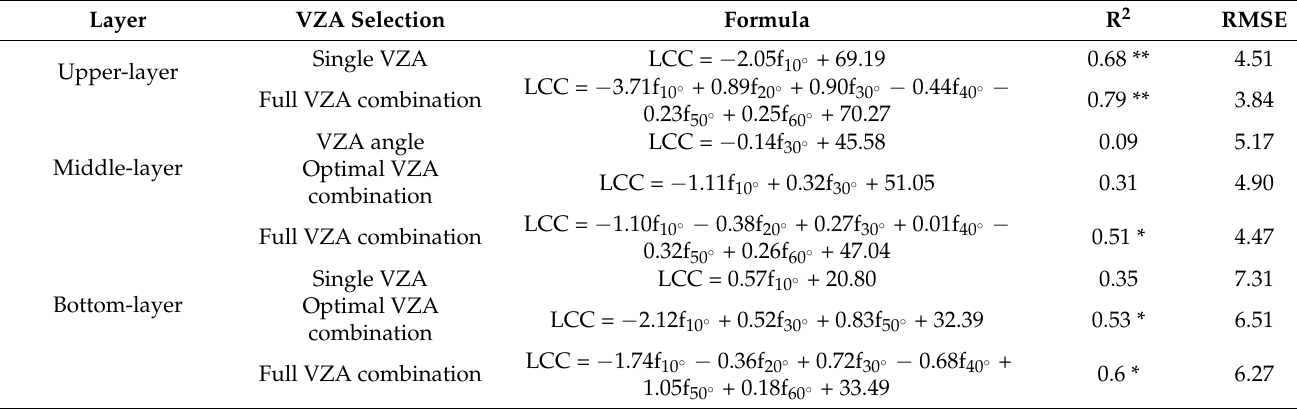
Table 8. Leaf chlorophyll content inversion strategies for the upper-, middle-, and bottom-layers using the